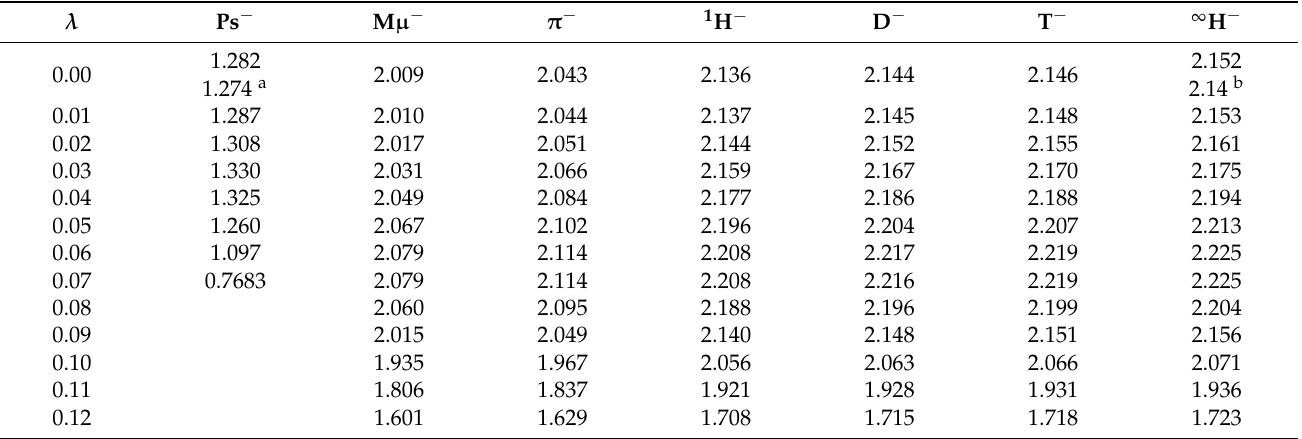
Table 4. 3 P o resonance widths Γ the screening parameter λ